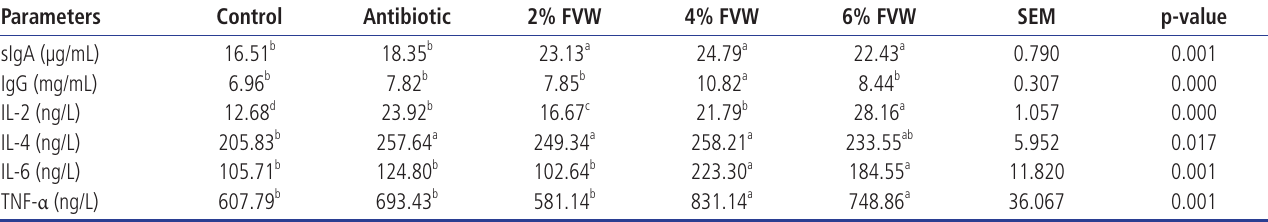
SEM, pooled standard error of the means; sIgA, serum immunoglobulin A; IgG, immunoglobulin G; IL, interleukin; TNF- α , tumor necrotic factor- α . 1) Data represented the mean value of 7 hens per treatment. a,b,c,d Means in the same row with different letters are significantly different